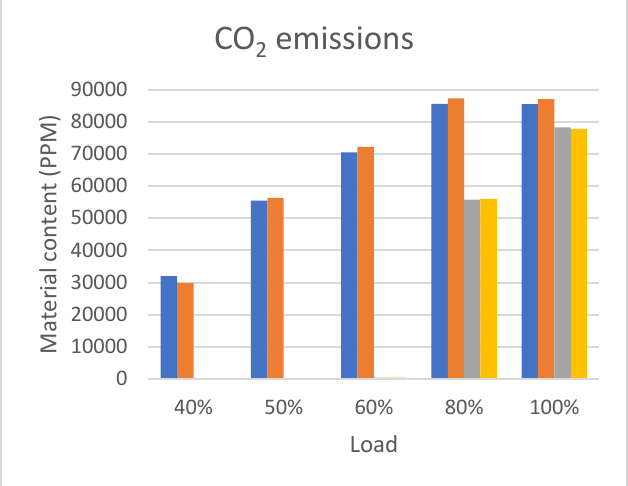
Figure 8. CO 2 emissions of the engine. Table 6. Measured CO 2 values.